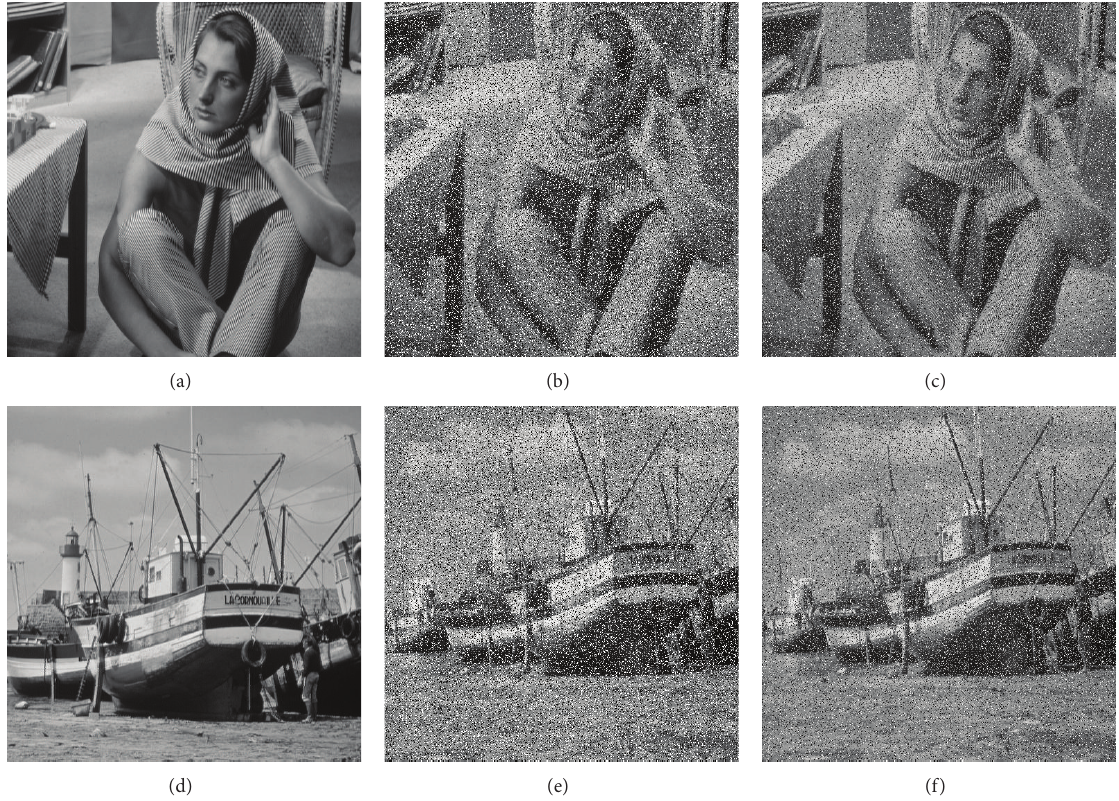
Figure 4: Images used in simulation. (a) and (d) are original images, Barbara (size 512 × 512) and Boat (size 512 × 512), respectively; (b) and (e) are the images corrupted with 30% salt-and-pepper noise; (c) and (f) are the images corrupted with 30% random-valued impulse noise.